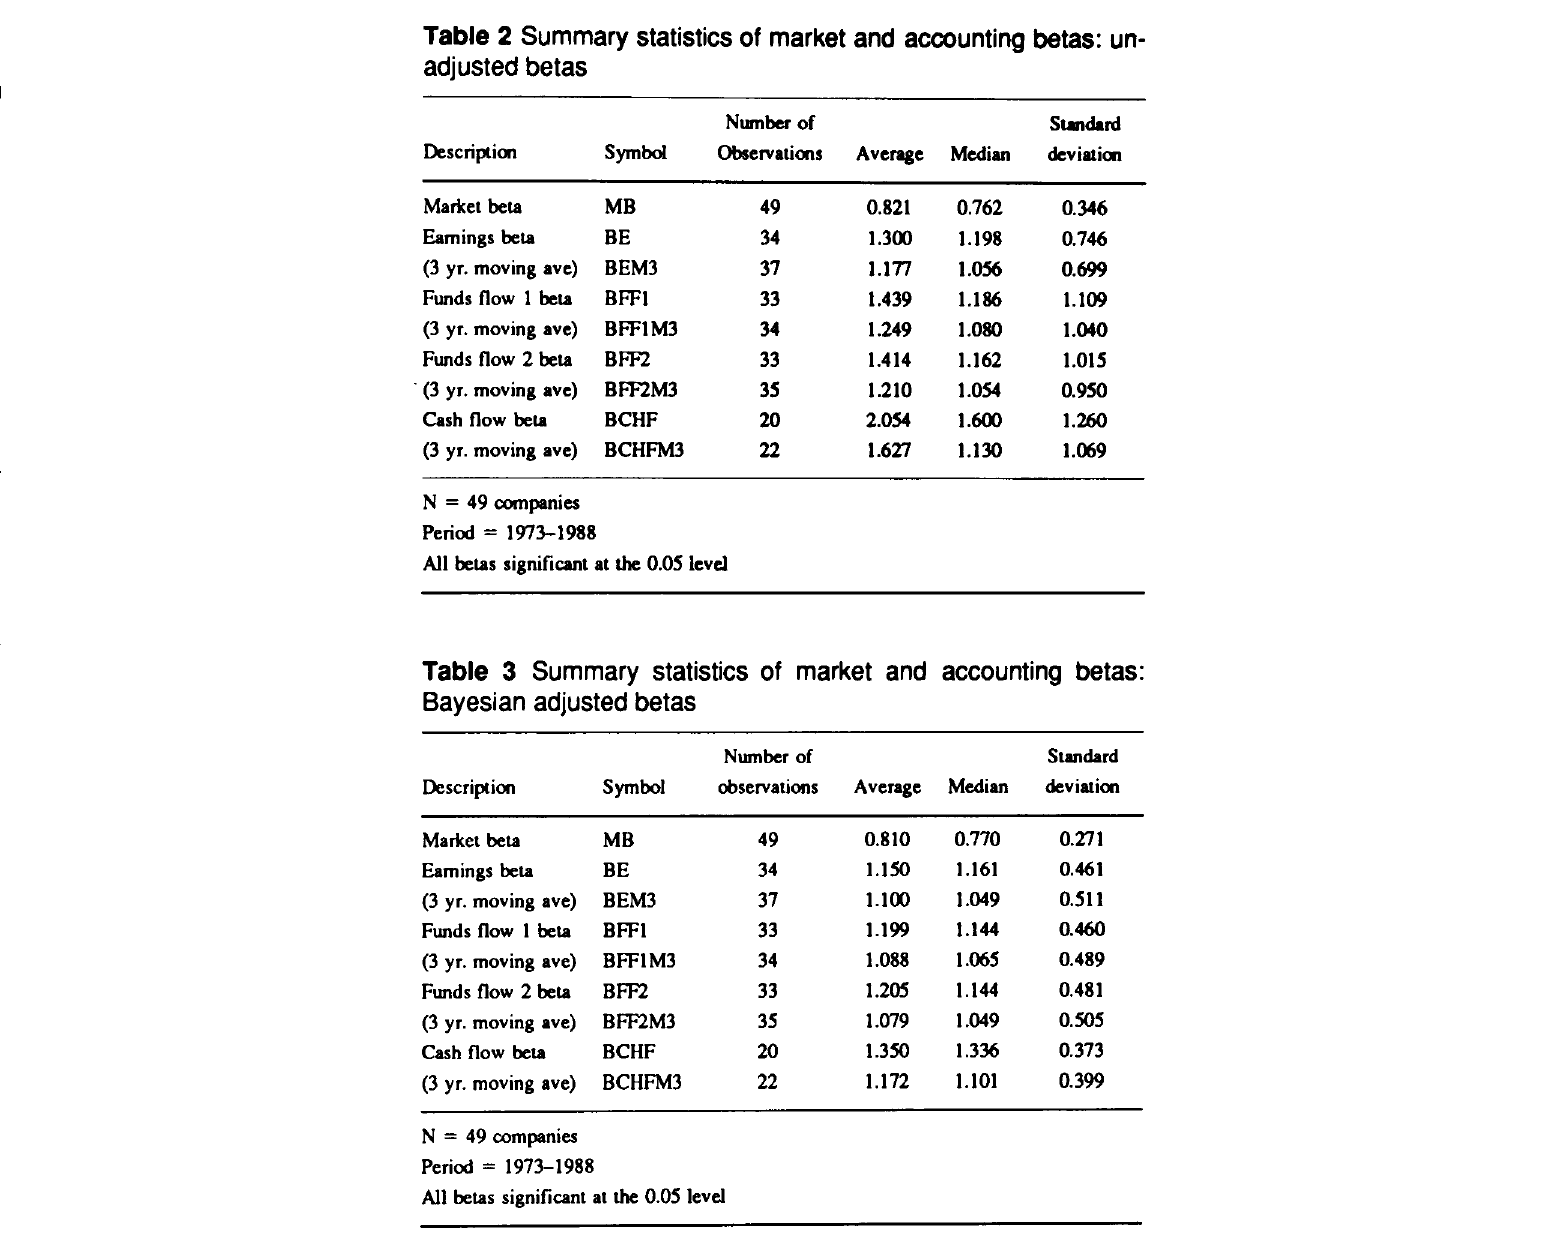
Table 3 Summary statistics of market and accounting